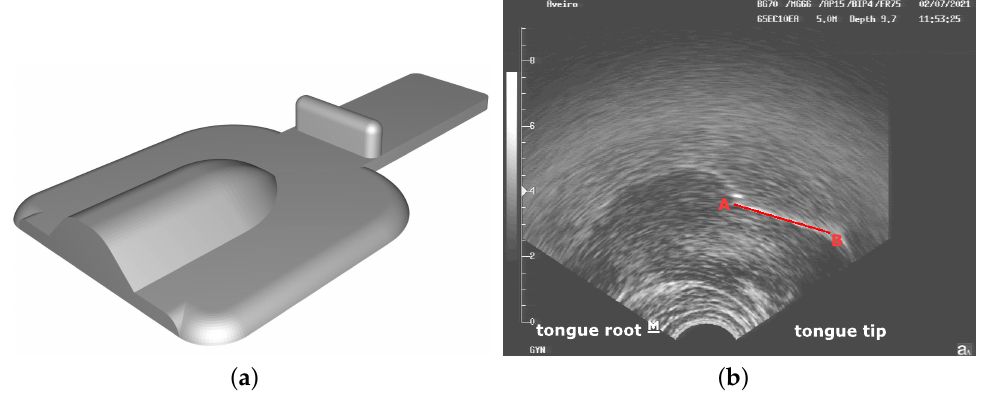
Figure 2. To ensure a common referential across blocks and sessions, US acquisitions were considered, including a bite plate ( a ). The corresponding images were annotated ( b ), and the data informed contour adjustment (e.g., rotation) before analysis. ( a ) Bite plate; ( b ) Bite plane